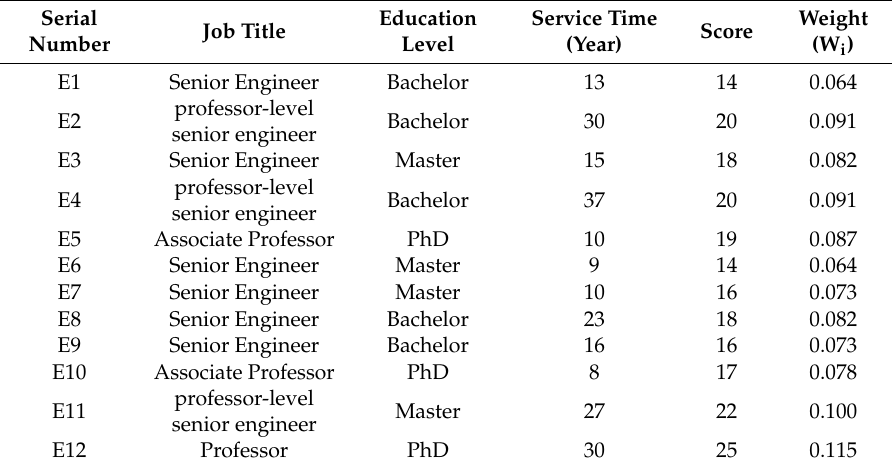
Table 3. Experts’